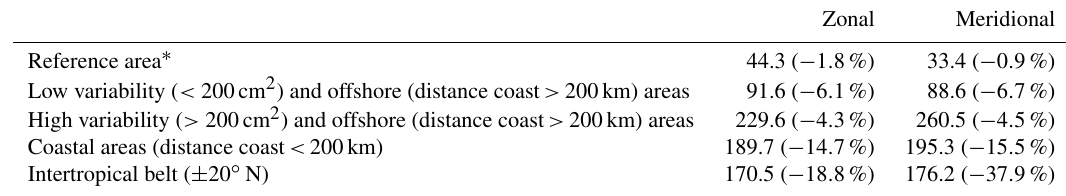
Table 4. Variance of the differences between gridded geostrophic current (L4) DT2018 products and independent drifter measurements (cm 2 s − 2 ). In parentheses: variance reduction (%) compared with the results obtained with the DT2014 products. Statistics are presented for latitude selection (5 ◦ N < | LAT | < 60 ◦ N).